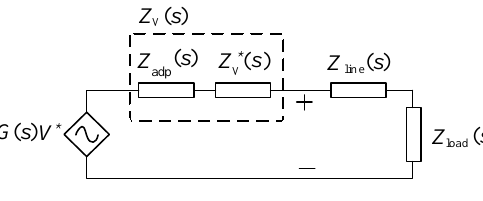
Figure 5. Equivalent circuit of DG.